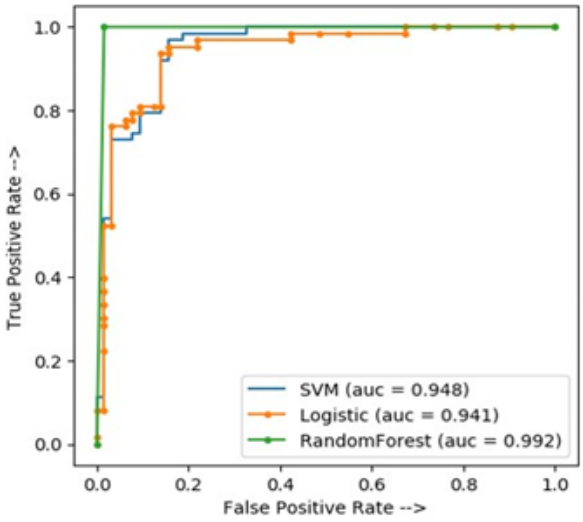
Figure 4. ROC curve comparisons of different